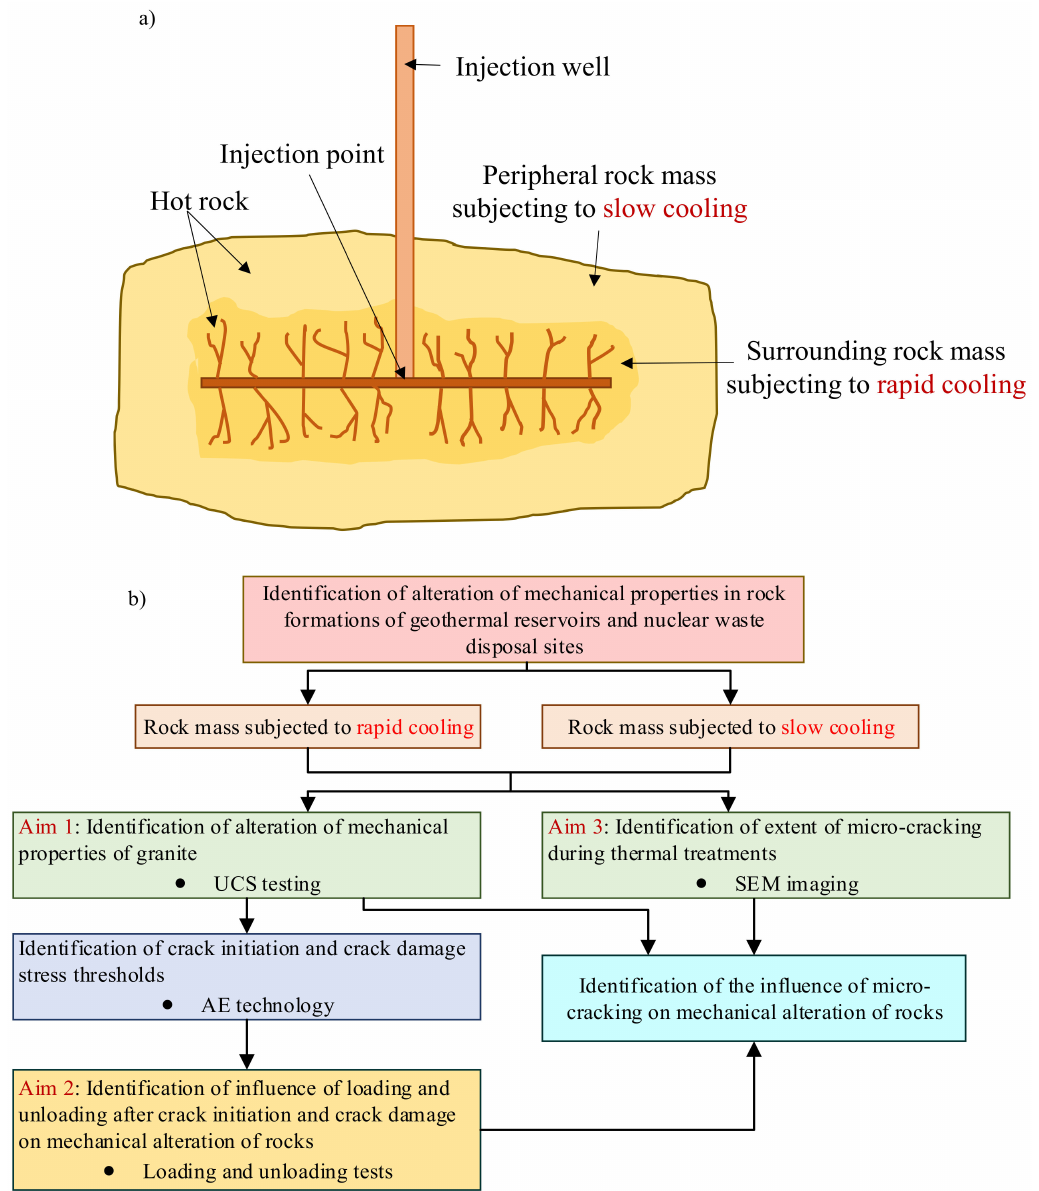
Figure 3. ( a ) Schematic diagram of a hot rock mass which undergoes cooling during fluid injection and ( b ) the flow of the experimental work covered by the